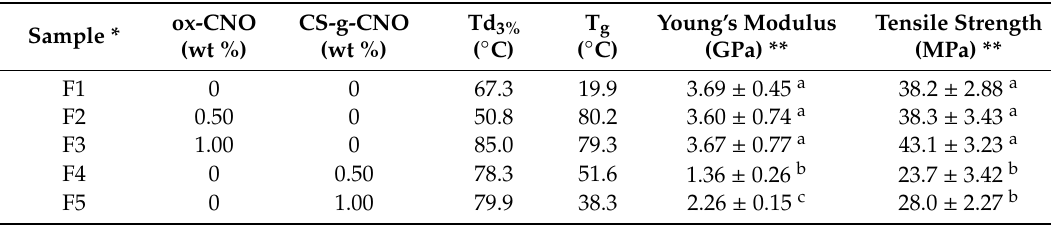
Table 1. Td 3% , Young’s modulus, and glass transition temperature (T g ) of the di ff erent film formulations